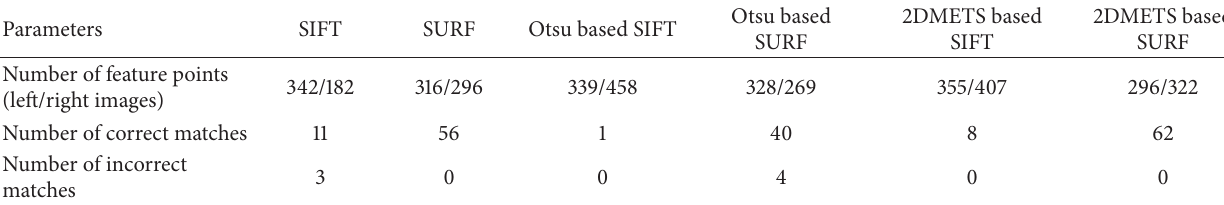
Table 4: Matching performance for images in group